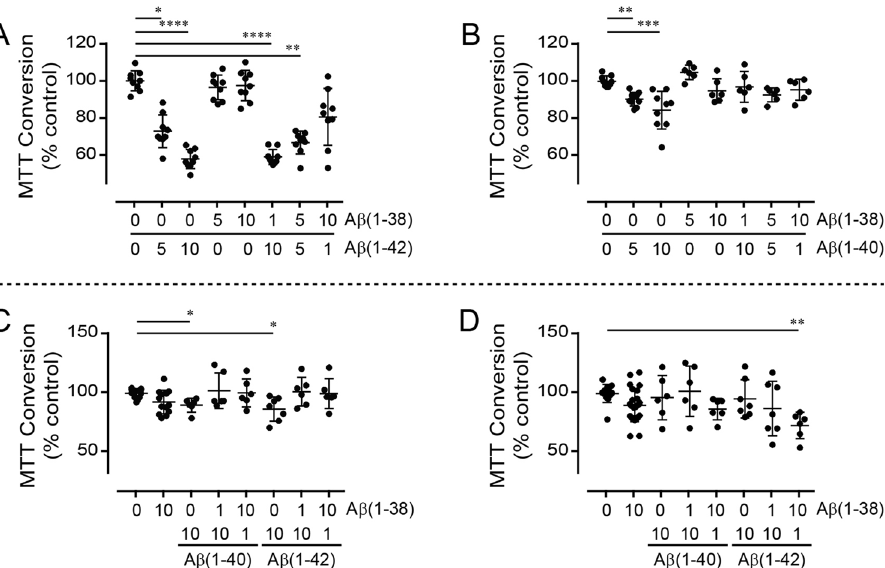
Figure 4. Mitochondrial metabolism (MTT conversion) used as a reflection of cell health in Aβ-treated murine hippocampal neuronal cells and human fibroblast cultures. The HT-22 cell cultures (n = 6–9) were treated (24 h) with concentrations of ( A ) Aβ(1–38) and Aβ(1–42) or ( B ) Aβ(1–38) and Aβ(1–40), as indicated along the X-axis (labels are in µM). ( C ) APOE ε4-positive and ( D ) APOE ε4-negative fibroblast cultures (n = 6–12) were treated (24 h) with combinations of either Aβ(1–38), Aβ(1–40), and Aβ(1–42) as indicated along the X-axis (labels are in µM). *: P < 0.05; **: P < 0.01; ***: P < 0.001; ****: P < 0.0001 vs. ‘0/0 ′ -treated control